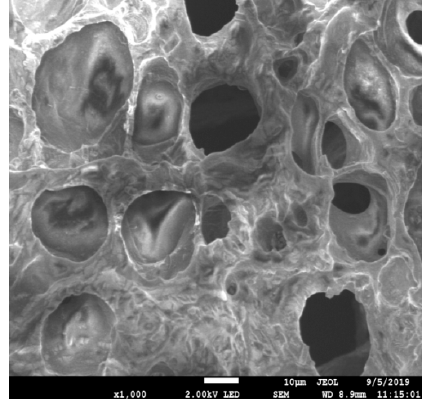
Figure 5. Polyacrylamide gel (HCT) microstructure.